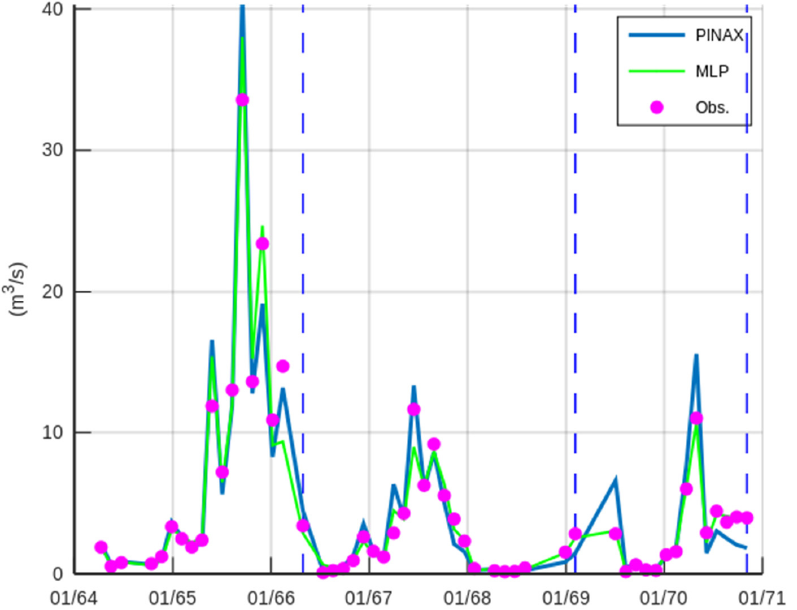
Figure 6. Sakoulevas case study—discharge calculated with the MLP, and discharge calculated with the 3 regression equations after partitioning data with PINAX. PINAX period 1 (02/1964–05/1966), PINAX period 2 (06/1966–05/1969), PINAX period 3 (06/1969–01/1972). The start and end of the periods are marked with the dashed vertical lines.